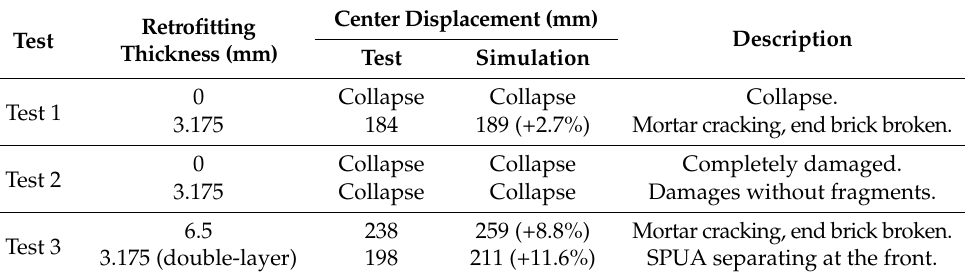
Table 5. Experimental and numerical results under different